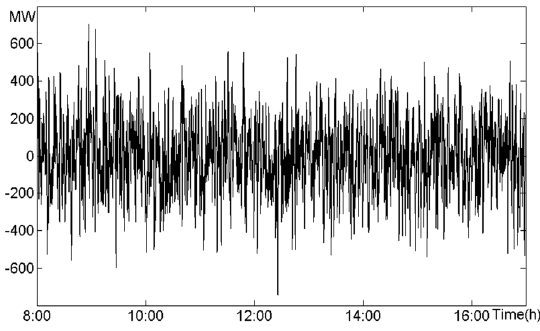
Fig. 8 Load fluctuation in a time series with 1 s intervals